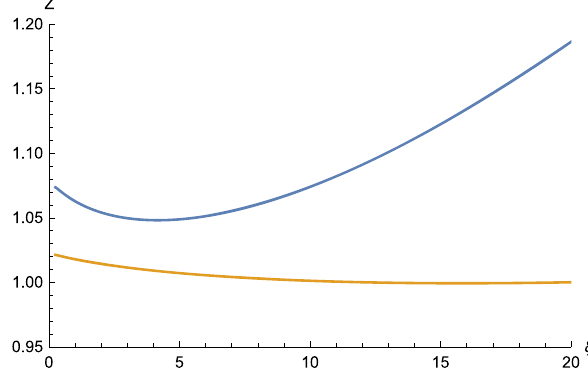
Fig. 3 Dependence of the residue Z for the gauge field propagator from the gauge parameter ξ , for Region I (blue), and Region II